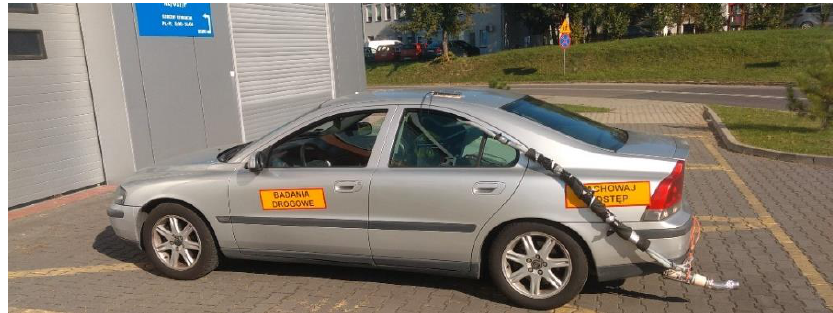
Figure 4. View of the tested vehicle with the portable emission measurement system (PEMS) system. Table 4. Specifications of the on-road emission test. Table 3. Selected technical parameters of the PEMS Horiba OBS-2200.